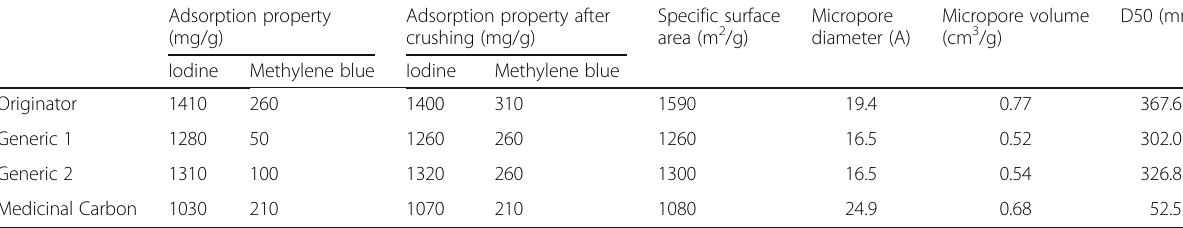
Table 6 Properties of spherical adsorbent carbon